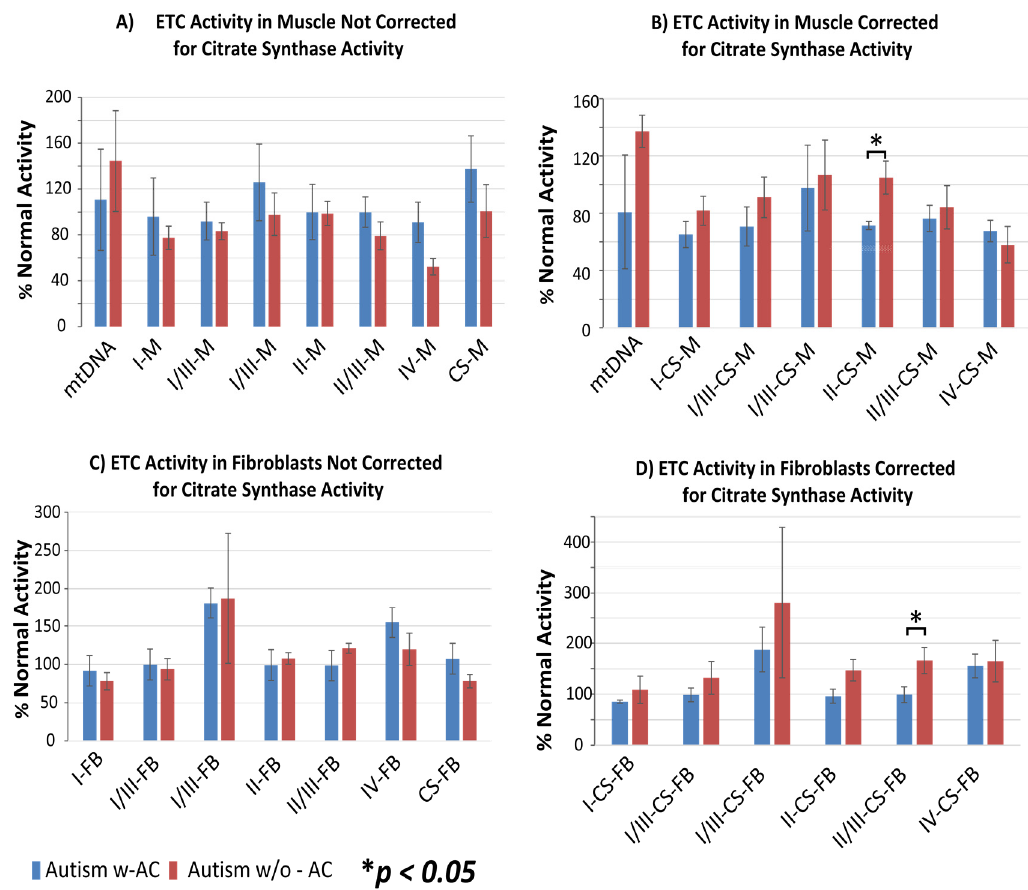
Figure 3. Electron transport chain (ETC) activity in muscle (M; Panels ( A , B )) and fibroblast (FB) culture (Panels ( C , D )) without (Panels ( A , C )) and with (Panels ( B , D )) correction for citrate synthase (CS) activity, in patients with autism spectrum disorder (ASD) that also have acyl-carnitine (AC) elevations (ASD w-AC, blue bars) and participants with ASD without AC elevations (ASD w/o-AC, red bars). Mitochondrial DNA copy number (mtDNA) is also provided in the graphs for muscle samples.